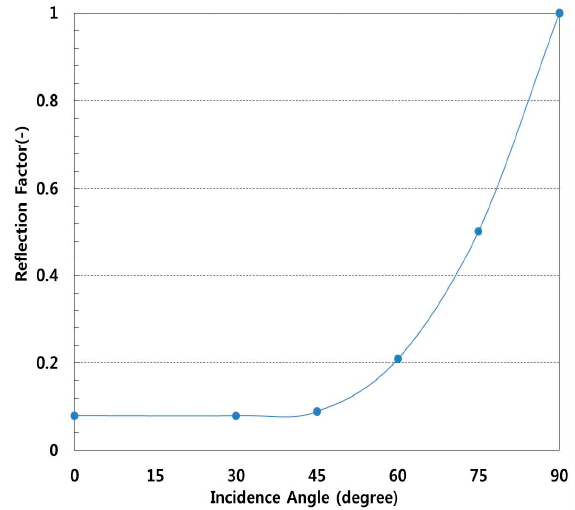
Figure 3. Reflection factor of glass material according to the incidence angle.